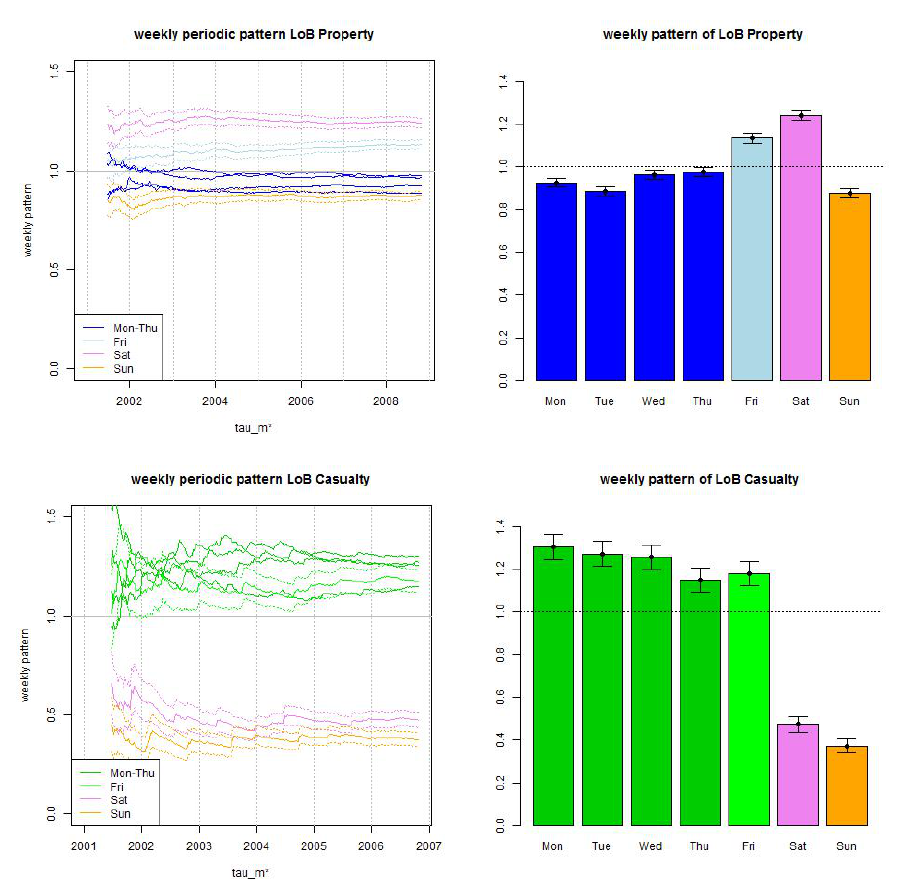
Figure 5. Weekly periodic pattern estimate ( (cid:98) λ k ) k = 1,...,7 (top) LoB Property and (bottom) LoB Casualty: (lhs) time series as a function of τ m ∗ and (rhs) for maximal τ m ∗ such that (11) holds at time τ m = 31/10/2010 for a maximal reporting delay of 2 years (LoB Property) and of 4 years (LoB Casualty). The confidence bounds in all plots are given by (12) for confidence level α =